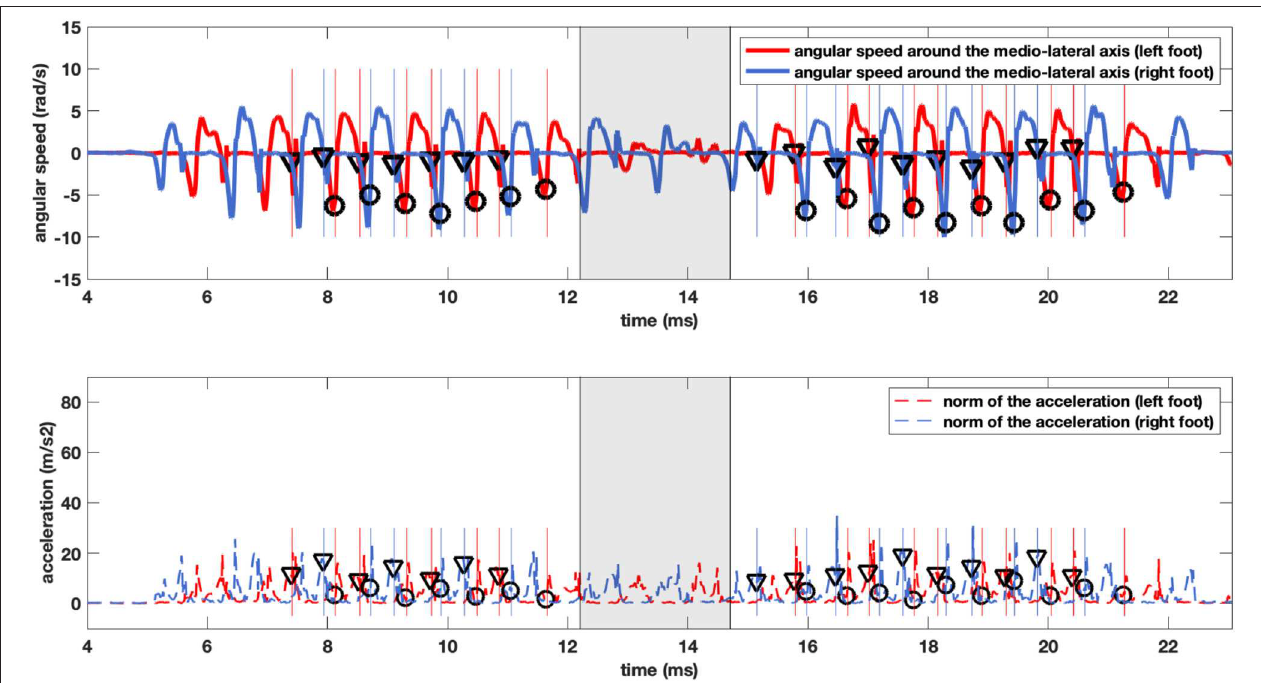
FIGURE 2 | Example traces of the results of the step detection method for a pMS individual. The lines represent medio-lateral axis angular velocity (upper panel) and the magnitude of the norm of the acceleration (lower panel) recorded from the right (blue) and left (red) feet. The vertical lines display the Initial and Final Contacts as defined by the GR, and the triangles and circles display the ICs (triangles) and FCs (circles) as detected by our method. The shaded zone delimits the U-turn and is excluded from the analysis.